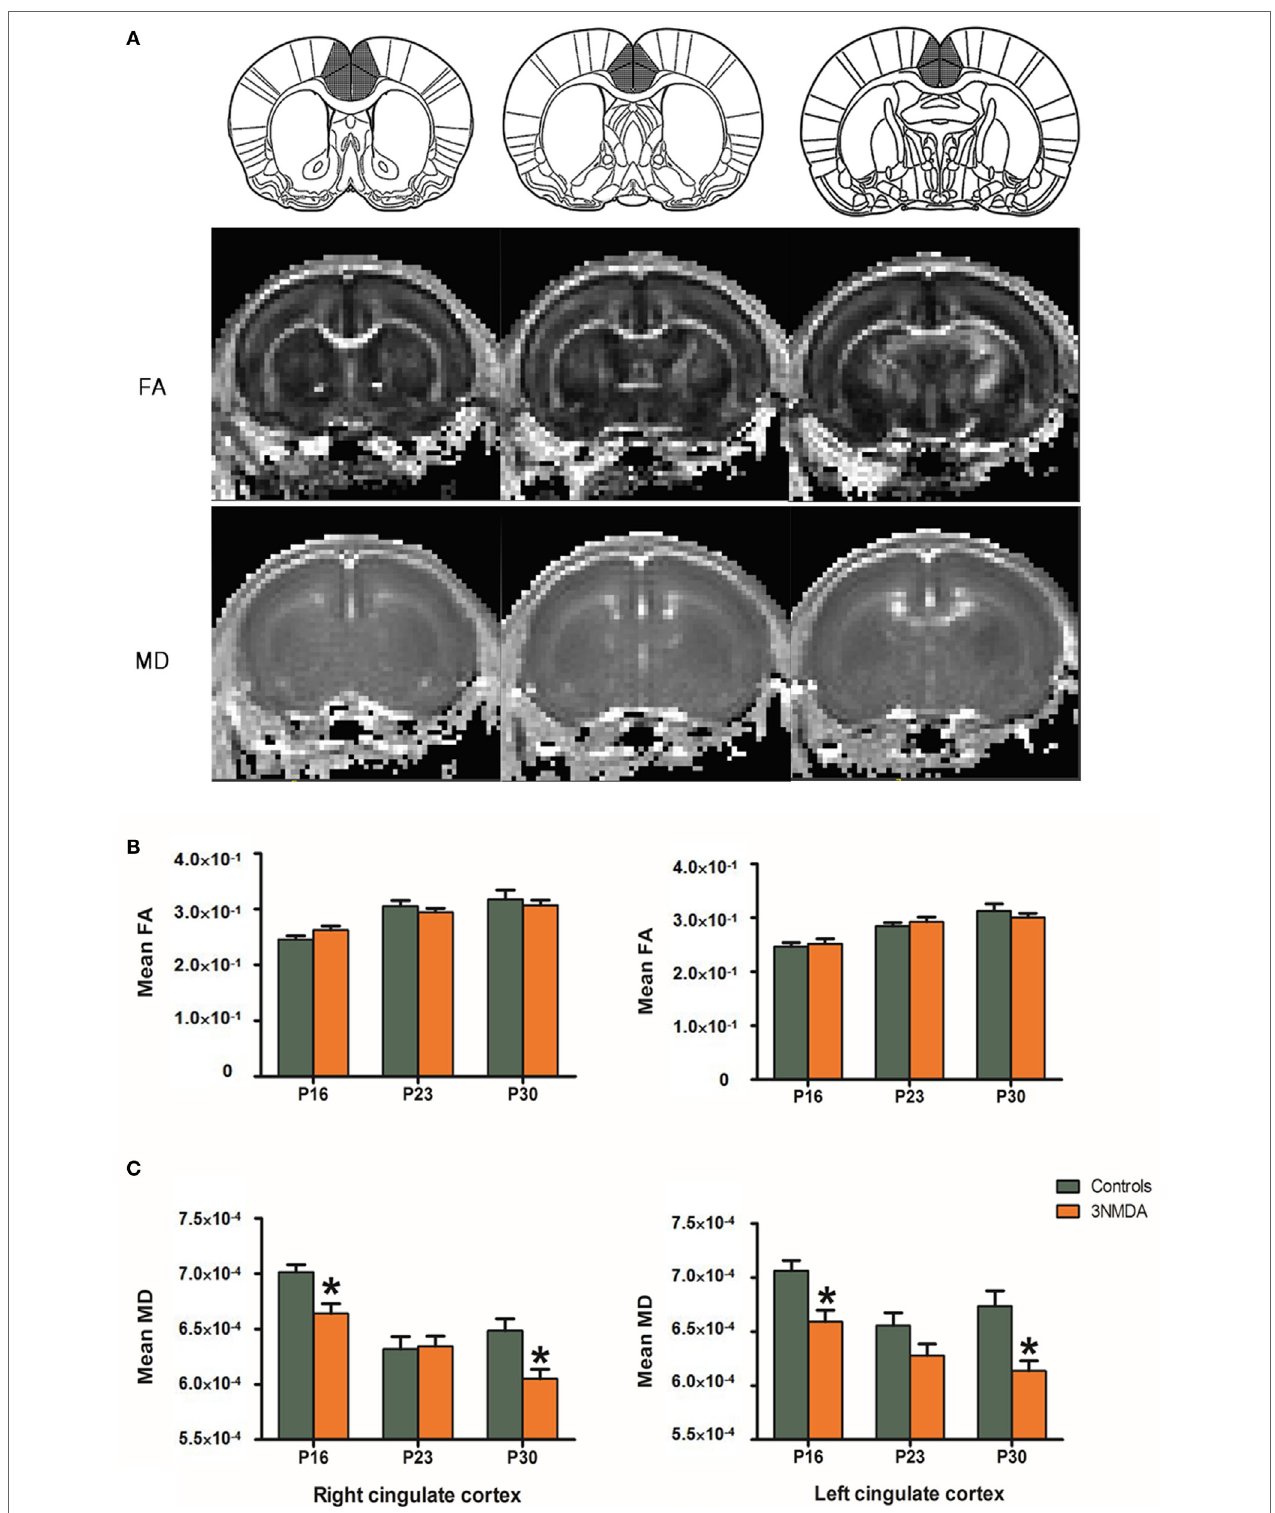
Figure 4 | (a) On diffusion tensor imaging of rats after N -methyl- d -aspartate (NMDA)-induced spasms and controls, fractional anisotropy (FA) and mean diffusivity (MD) were measured in the cingulate cortex of each animal. (B) The anatomical location of cingulate cortex was clearly identified on FA/MD maps of the rat at P16. (c) There were no significant differences in the FA values at each time point between the rats with spasms (N = 15) and controls (N = 15). Rats with multiple bouts of NMDA-triggered spasms showed a significantly decreased MD at P16 and P30 in both cingulate cortices compared with